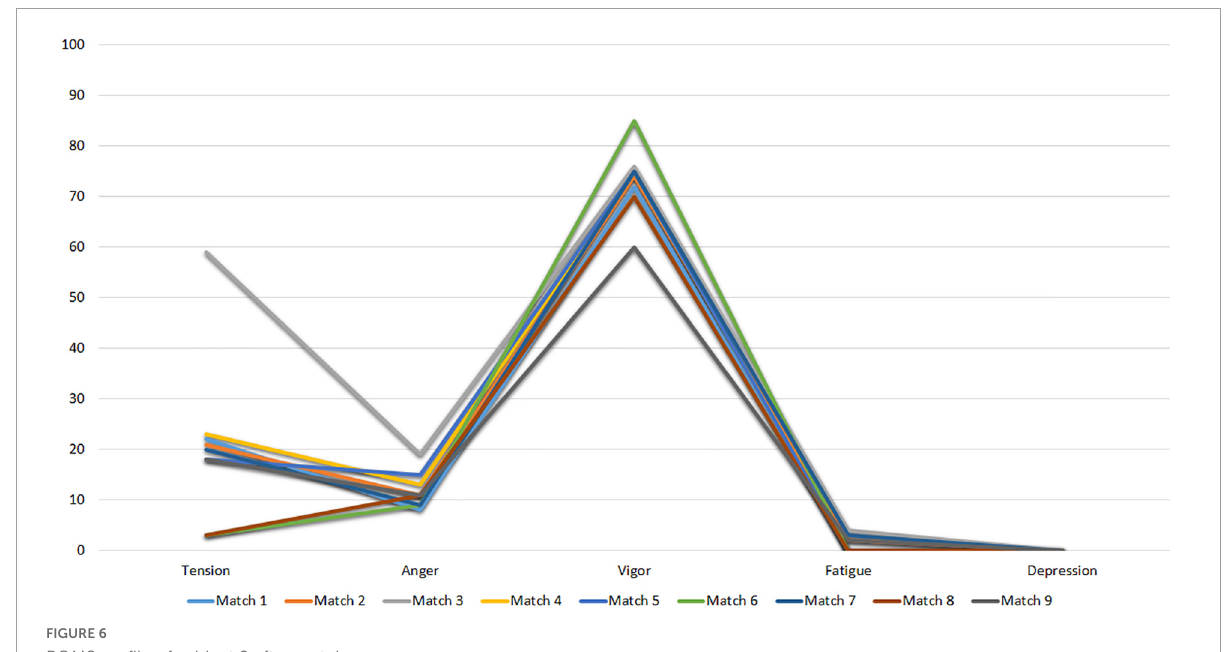
FIGURE6 POMS profile of subject 2 after matchs.